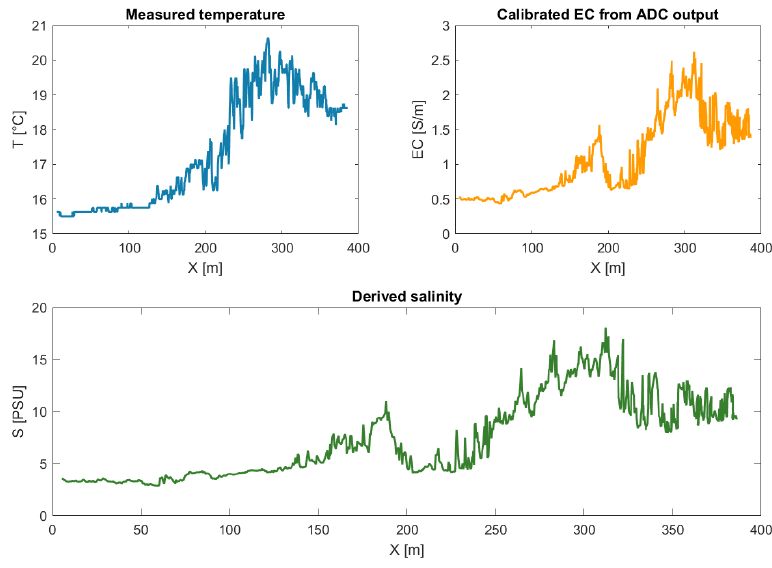
Figure 12. Derived salinity for Probe 9, Realization